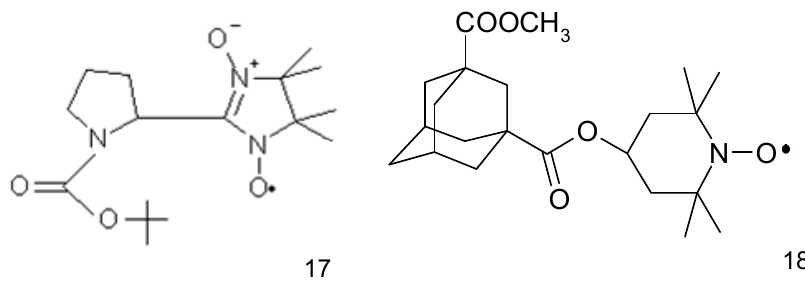
Figure 5. Nitroxides used as anticancer drugs: ( 17 ) L-NNP and ( 18 ) adamantyl nitroxide derivative.